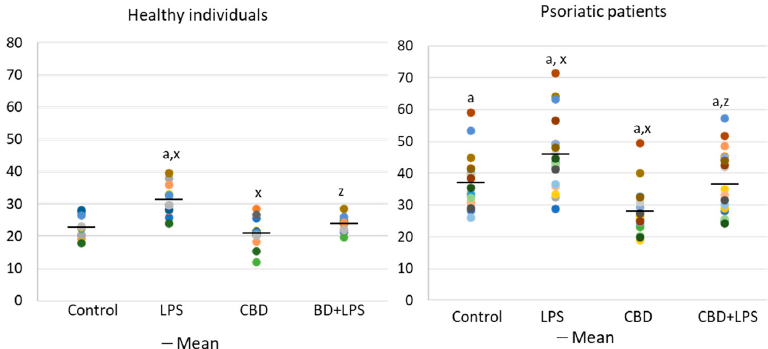
Figure 3. Level of myeloperoxidase (MPO) (ng/mL) in supernatants obtained after 1h neutrophils from healthy subjects ( n = 14) and psoriatic patients ( n = 28) incubation with LPS, cannabidiol and LPS with cannabidiol. a—statistically significant difference between neutrophils from psoriasis vulgaris and healthy subjects p < 0.05; x—statistically significant difference between treated neutrophils (with LPS, CBD, or LPS + CBD) and non-treated (control) cells; p < 0.05; z—statistically significant difference between neutrophils treated with LPS + CBD and treated only with LPS; p < 0.05.